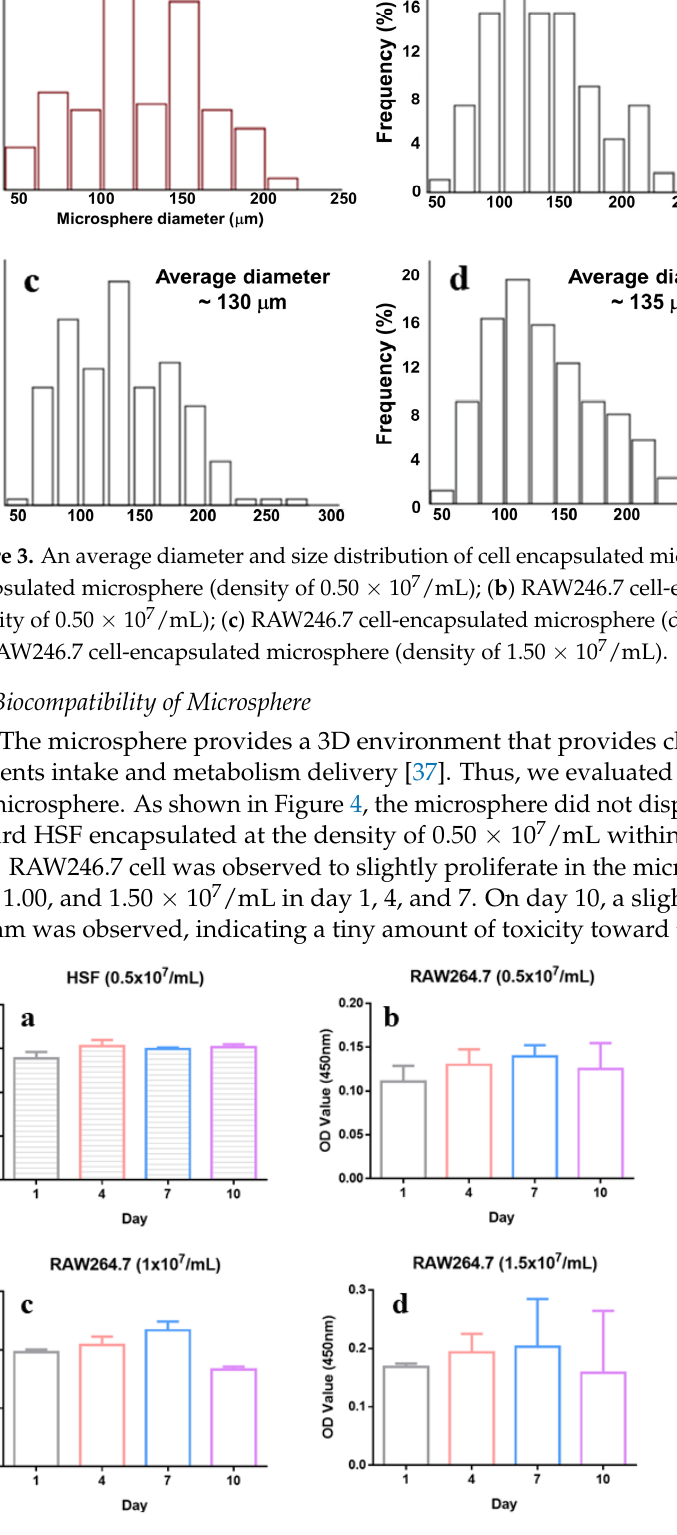
Figure 4. Cell viability of encapsulated HSF and RAW246.7 cells on different days: ( a ) HSF cells encapsulated at the density of 0.50 × 10 7 /mL; ( b ) RAW246.7 cells encapsulated at the density of 0.50 × 10 7 /mL; ( c ) RAW246.7 cells encapsulated at the density of 1.00 × 10 7 /mL; ( d ) RAW246.7 cells encapsulated at the density of 1.50 × 10 7 /mL.